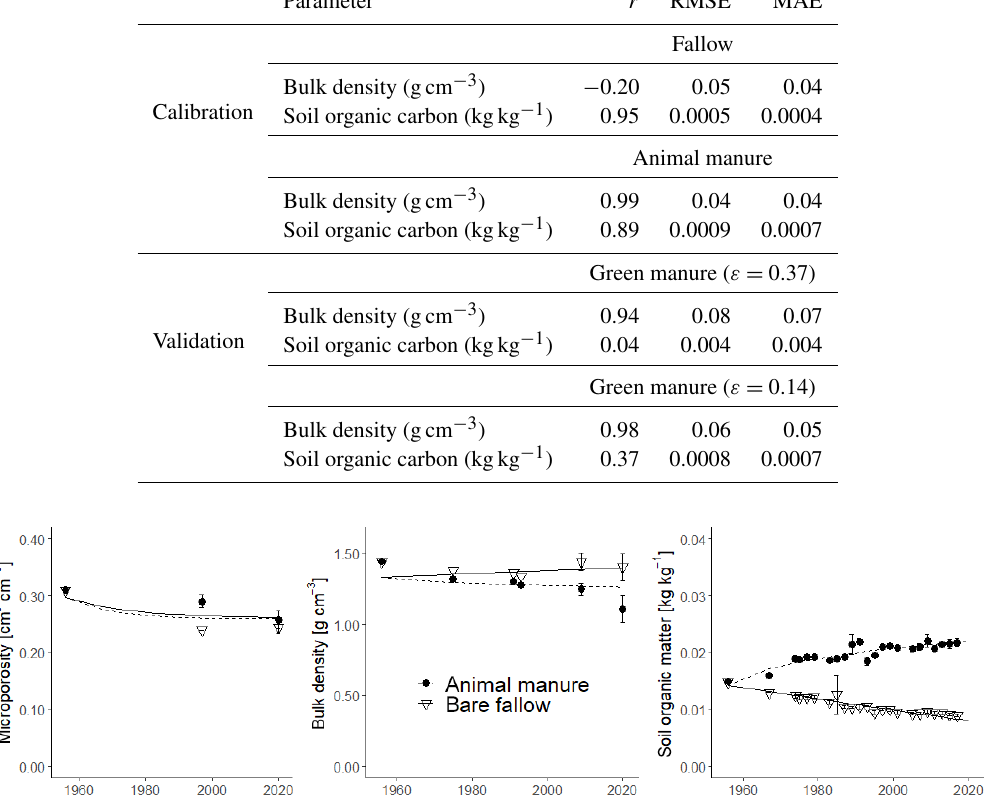
Figure 8. Observed (symbols; bars show standard deviations) and simulated (lines) microporosity (cm 3 cm − 3 ), bulk density (gcm − 3 ) and soil organic carbon concentration (kgkg − 1 ) for the fallow and animal manure